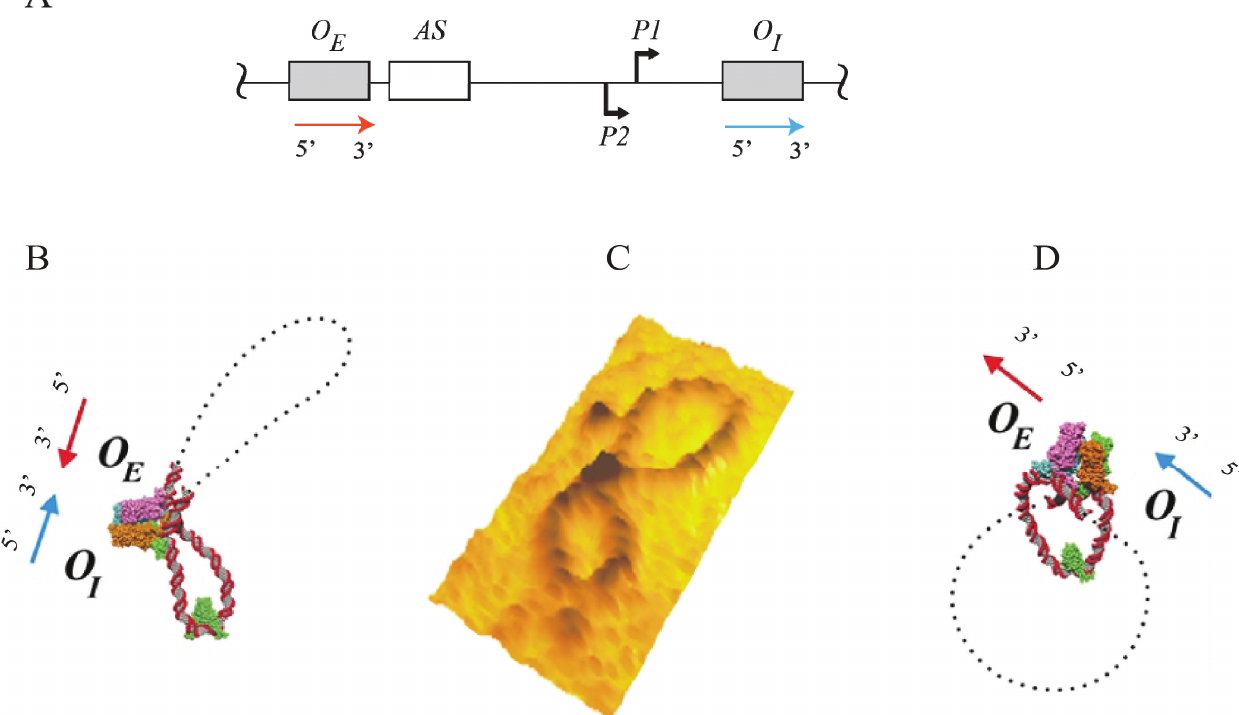
(AFM) on DNA minicircles of 688-bp with a figure-of-eight structure containing two loops: a 113-bp loop and a large loop of 555-bp as expected [71]. However, the geometry of the loop (antiparallel or parallel) is not distinguishable by this AFM image because of the positions of the two operators in the 688-bp plasmid. To address the geometry of the loop, minicircles of 599-bp containing an additional 84-bp insertion between O E and O I is used to show a small loop size of 197-bp and a larger loop of 402-bp with GalR and HU (Figure 11) [72]. The geometry of the DNA loop (Figure 11C) is antiparallel (Figure 11B) and not parallel (Figure 11D). AFM study with LacI and lac operators containing the same size DNA ( lac operators replaced the gal operators) also reveals an antiparallel loop [72].